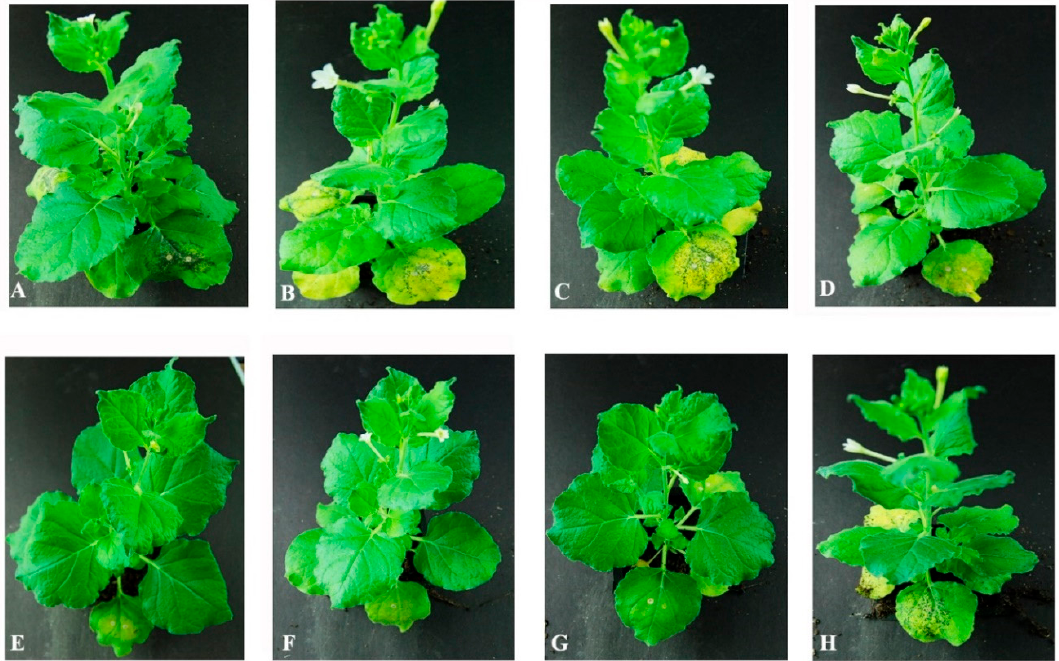
Figure 3. Determination of the functional domain of CLIBASIA_05150. To determine the functional domain of CLIBASIA_05150, deletion assay was performed. Pictures were taken at 6 DPI. ( A ) The full length of CLIBASIA_05150 (cell death); ( B ) deleted 1 / 3 from N-terminal (cell death); ( C ) deleted 1 / 3 from middle (cell death); ( D ) deleted 1 / 3 from C-terminal (no cell death); ( E ) only included the C-terminal